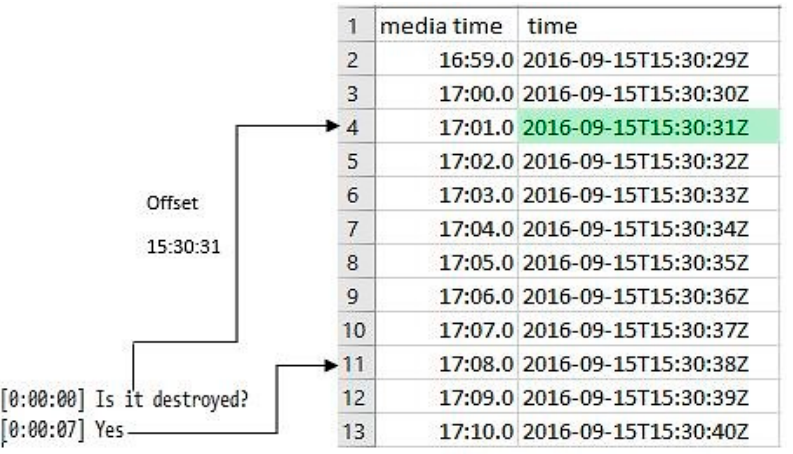
Figure 2. Illustration of the GPS record to narrative mapping.